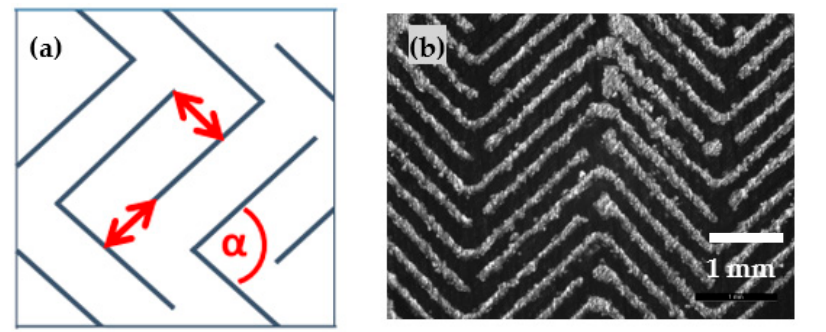
Figure 10. Anisotropic structure. ( a ) Schematic structure with laser line scan (blue lines), hatch distance (red arrow) and triangular opening angle α . ( b ) Microscopic image of the structure with an opening angle α = 90°.